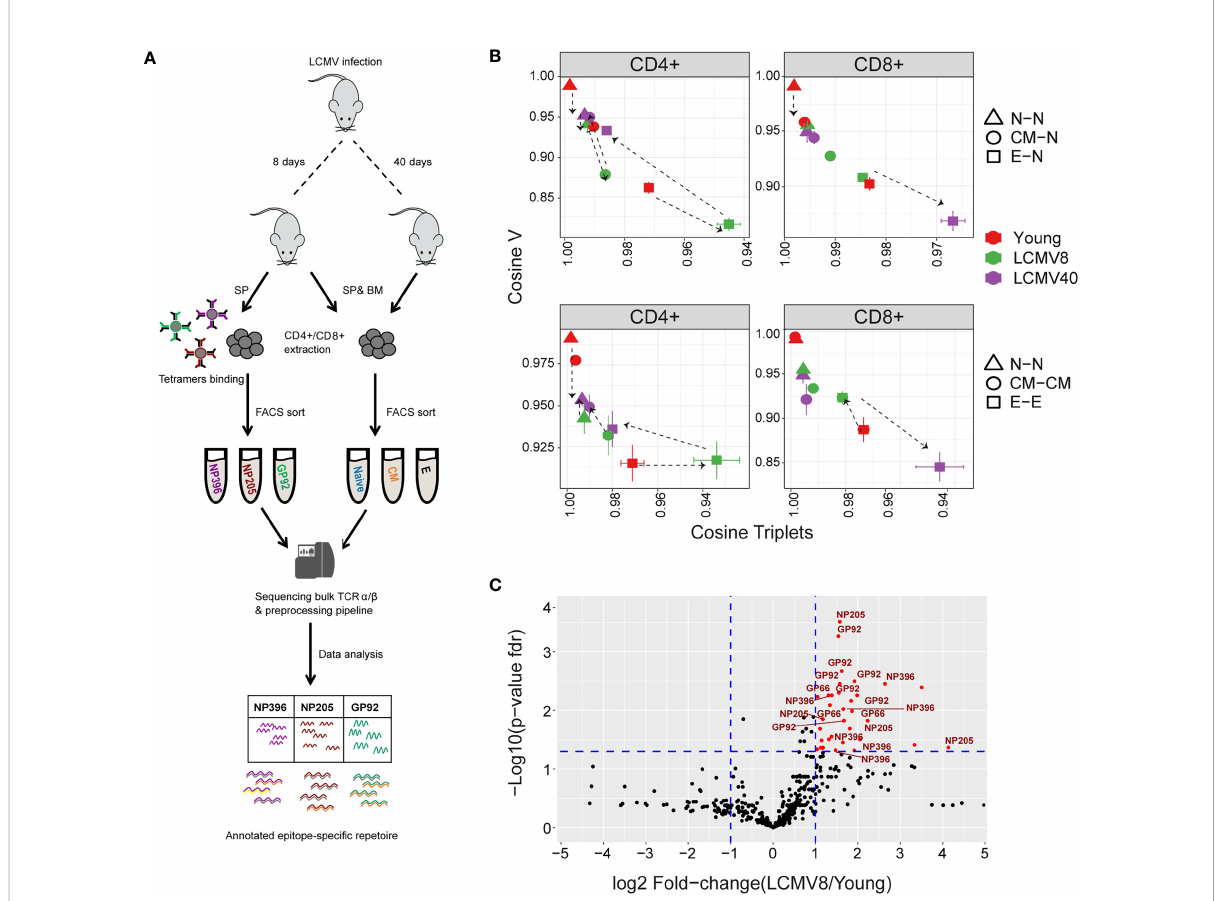
FIGURE 6 The impact of LCMV infection on repertoire organization. (A) Summary of the LCMV induced T cell compartments and epitope – speci fi c cells isolation for TCR repertoire sequencing and analysis. (B) The mean inter-repertoire cosine similarity values of the V b gene distribution versus the mean inter-repertoire cosine similarity values for the 350 most abundant CDR3 b AA triplets. In the upper panel each repertoire (spleen only) from LCMV infected mice is compared to the young naive repertoires for CD4+ and CD8+ compartments. In the lower panel each repertoire (spleen only) is compared to each other repertoire from the same compartment. The error bars represent SEM. (C) Triplets over-represented in CD8+ effector repertoires after 8 days of LCMV infection compared to young uninfected healthy mice. Each dot represents a single triplet. The y-axis shows FDR-adjusted t-test p-values. The x-axis shows the log 2-fold-change, calculated between mean triplets from young and LCMV infected mice (6-8 samples in each). Signi fi cance thresholds are marked in blue lines: at y=1.3 (equivalent to p-value of 0.05) and x= ± 1 (denoting a total fold-change of 2). Representative triplets above both thresholds are labeled with red text and dots. Signi fi cantly enriched triplets that are labeled in red text are also found in the TCRs of epitope speci fi c (NP396, NP205, and GP92 tetramer sorted) T